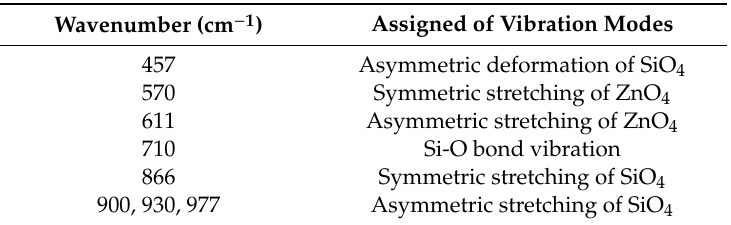
Figure 3. Fourier transform infrared reflection (FTIR) pattern of 55ZnO–5B 2 O 3 –40SLS glass and glass-ceramic sample at various heat-treatment temperatures. Table 2. FTIR transmittance bands associated with assigned vibration modes.